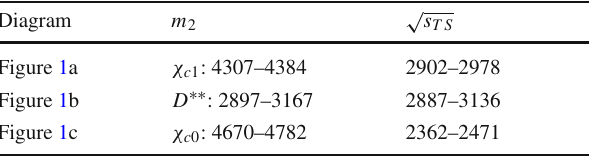
Table 1 TS kinematic region (all masses are real) corresponding to the rescattering diagrams in Fig. 1, in unit of MeV Diagram m 2 Figure 1a χ c 1 : 4307–4384 2902–2978 Figure 1b D ∗∗ : 2897–3167 2887–3136 Figure